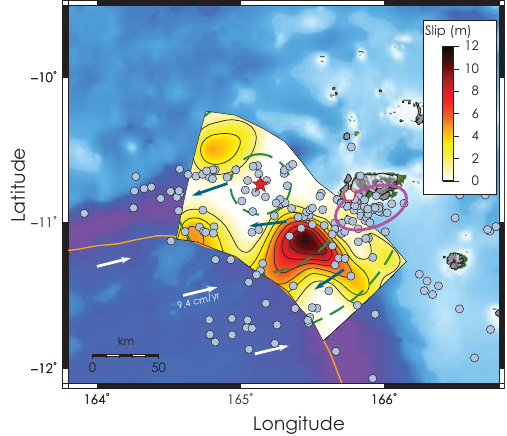
the easternmost, middle, and westernmost blocks equal to 90,